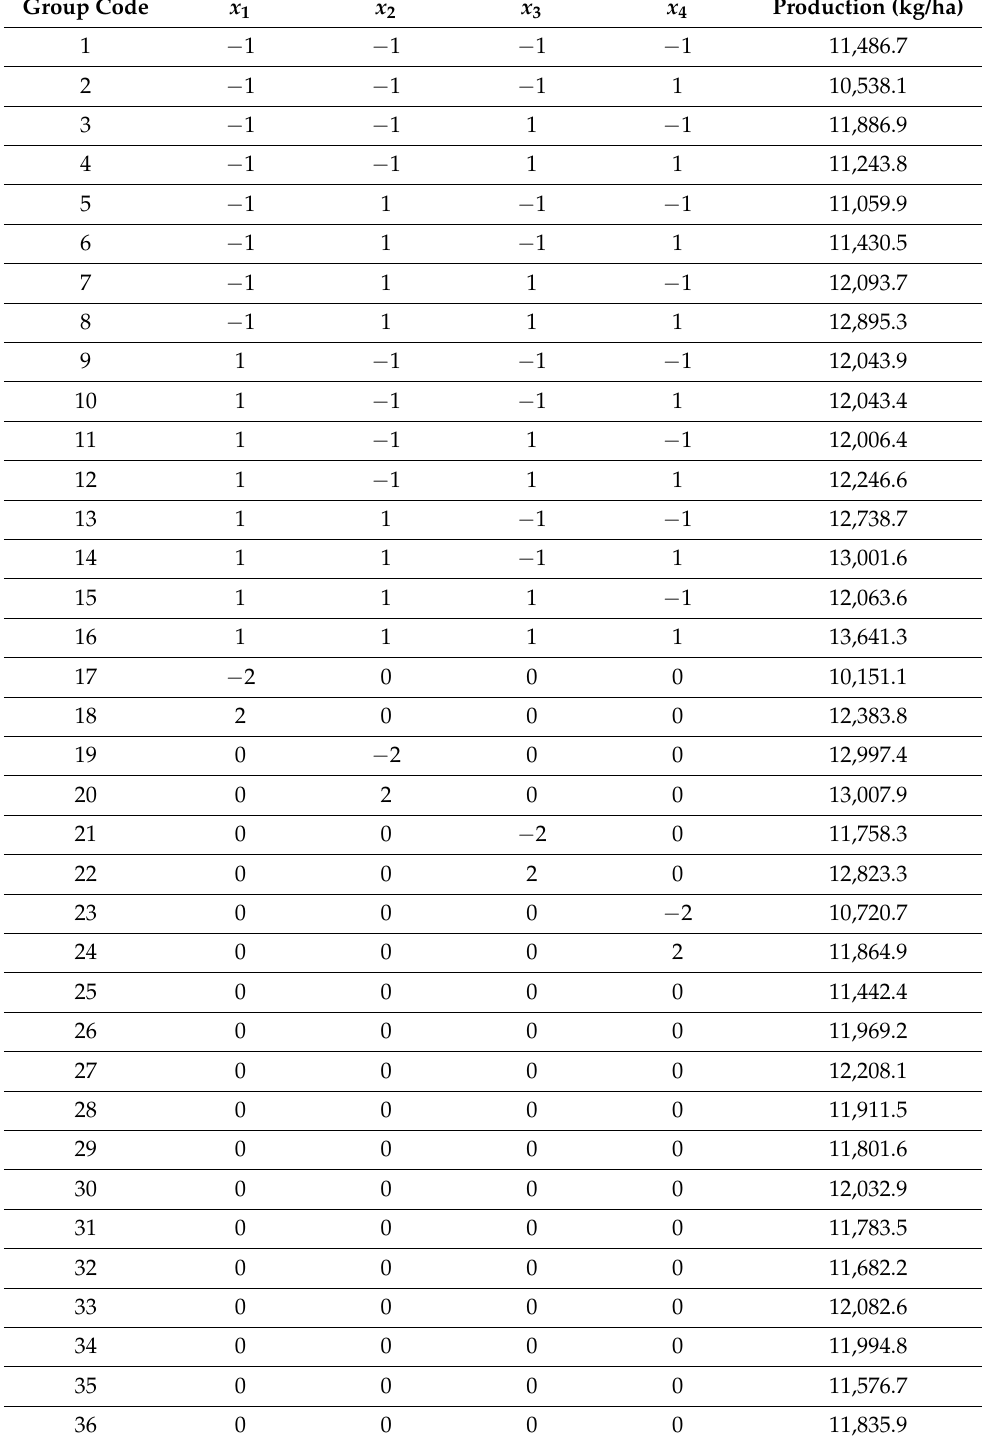
Table 2. Experiment structural matrix of the JLASTU